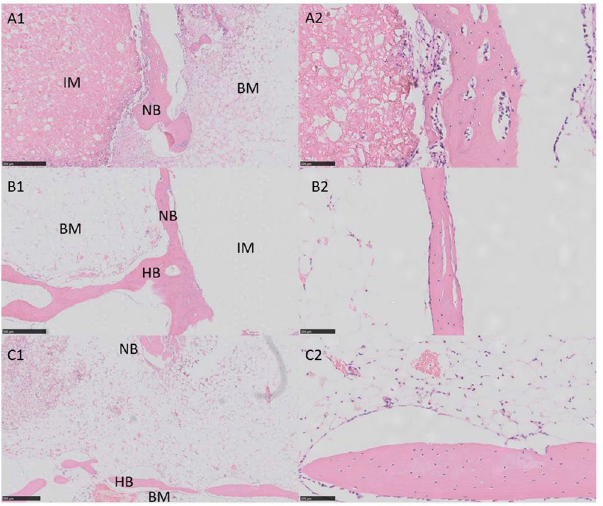
Figure 6. Histology photomicrographs of H&E staining of bone defects for three groups after 12 weeks. Abbreviations and signs used: newly bone (NB), host bone (HB), the implanted material (IM), bone marrow (BM). Scale bar represents 500 μ m (left row) and 100 μ m (right